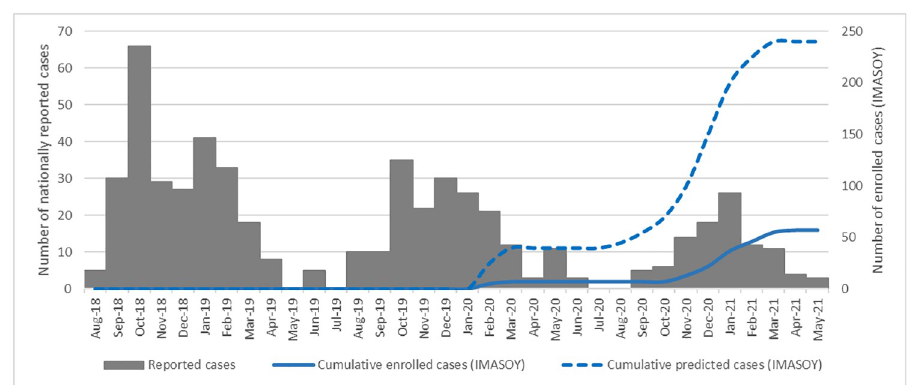
Fig 2. The number of suspected plague cases notified to the national plague programme from August 2018 to May 2021 shown against actual and predicted cumulative enrolment to the IMASOY trial. https://doi.org/10.1371/journal.pntd.0010064.g002 Table 2. Number (%) of confirmed cases of plague reported to the Central Plague Laboratory and number (%) of confirmed cases of plague included in the IMASOY trial (February 2020—April 2021). N confirmed and probable cases reported to the N (%) confirmed cases included in the Central Plague Laboratory IMASOY